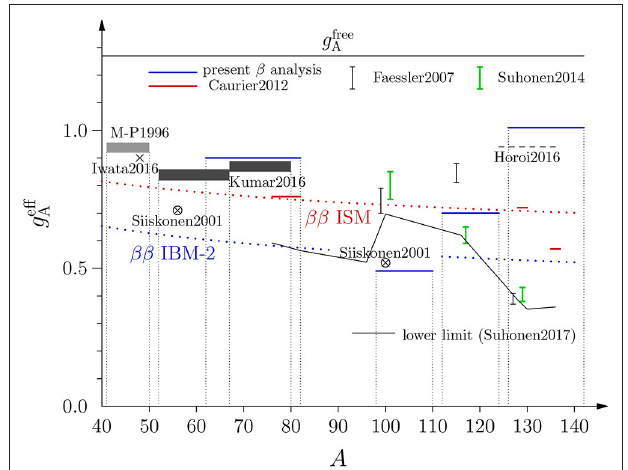
FIGURE 8 | Effective values of g A in different theoretical β and 2 νββ analyses for the nuclear mass range A 41 142. The quoted references of 2 νββ = − studies are Suhonen2017 [39], Caurier2012 [5], Faessler2007 [40], Suhonen2014 [ 41] and Horoi2016 [6]. These studies are contrasted with the ISM β -decay studies of M-P1996 [42], Iwata2016 [7], Kumar2016 [43] and Siiskonen2001 [44]. The red and blue dotted lines show the results of the analysis in Barea et al. [ 8] and quoted in Equation (21).